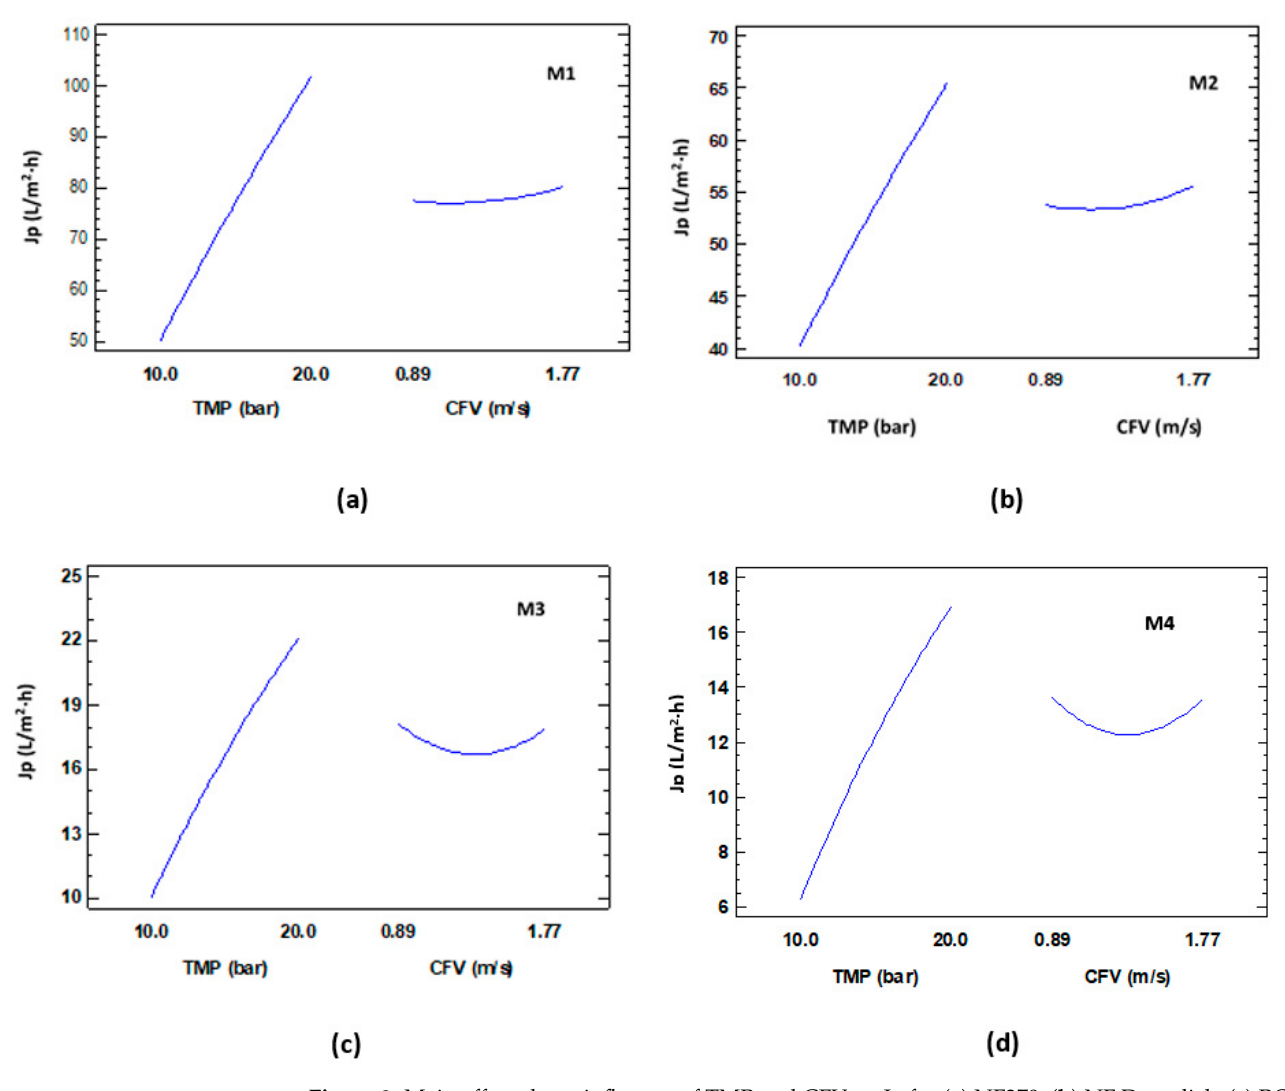
Figure 3. Main effect chart: influence of TMP and CFV on J p for ( a ) NF270, ( b ) NF Duraslick, ( c ) RO Duraslick, and ( d ) SWC3.